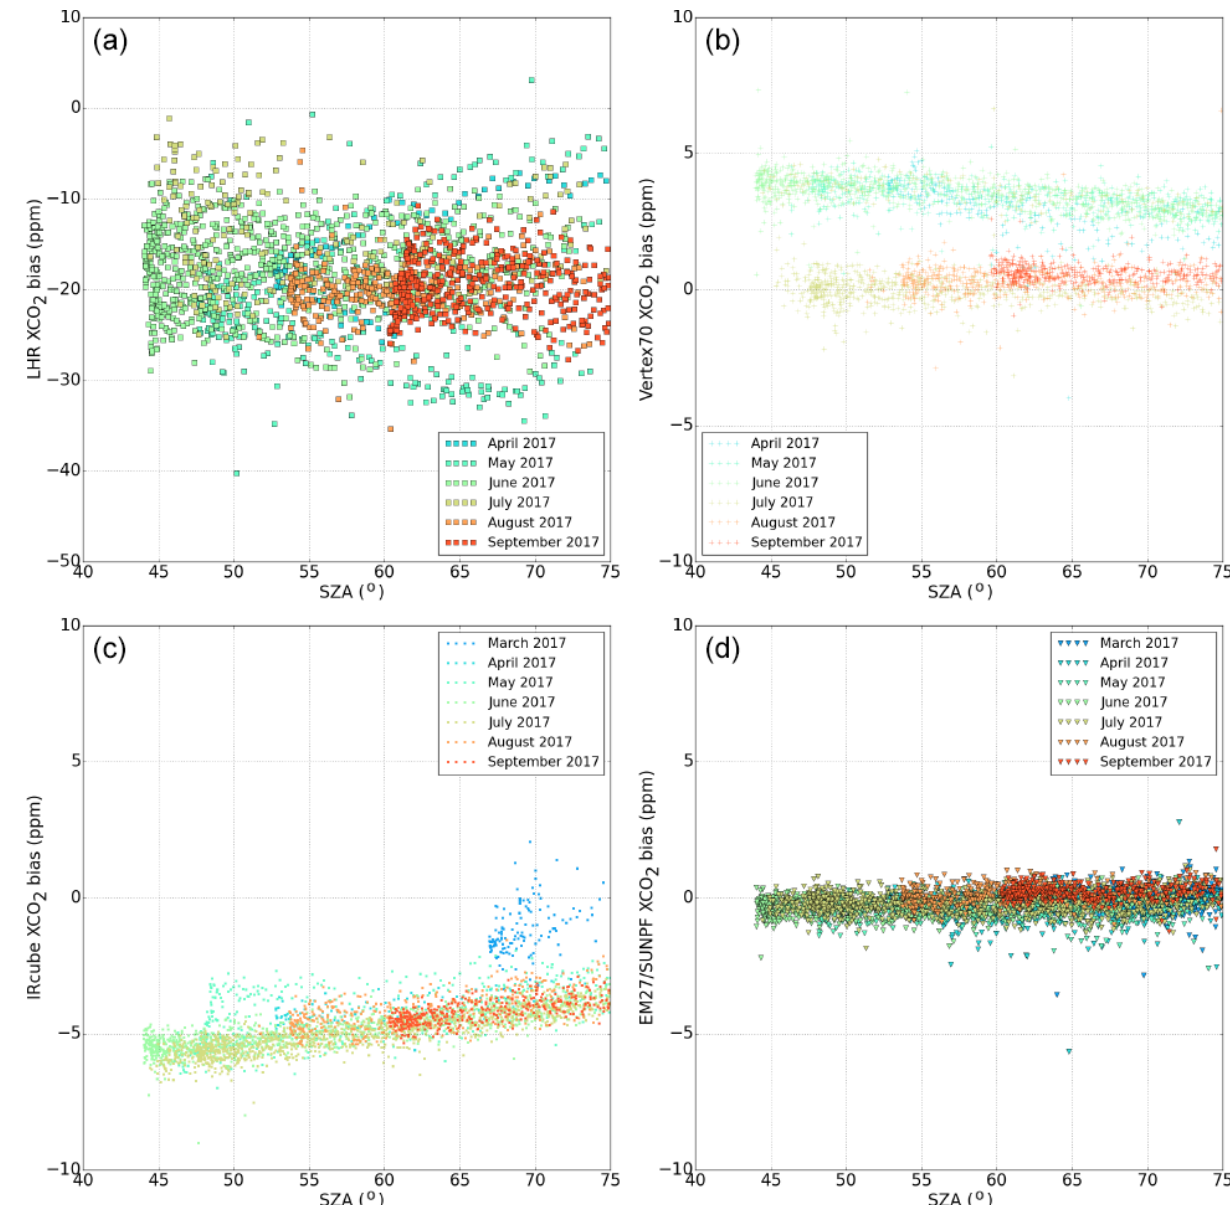
Figure E1. XCO 2 bias relative to TCCON for each instrument plotted with respect to the solar zenith angle: LHR (a) , Vertex70 (b) , IR- cube (c) , EM27/SUN (d) . The colours represent the measurement performed during the different months of the